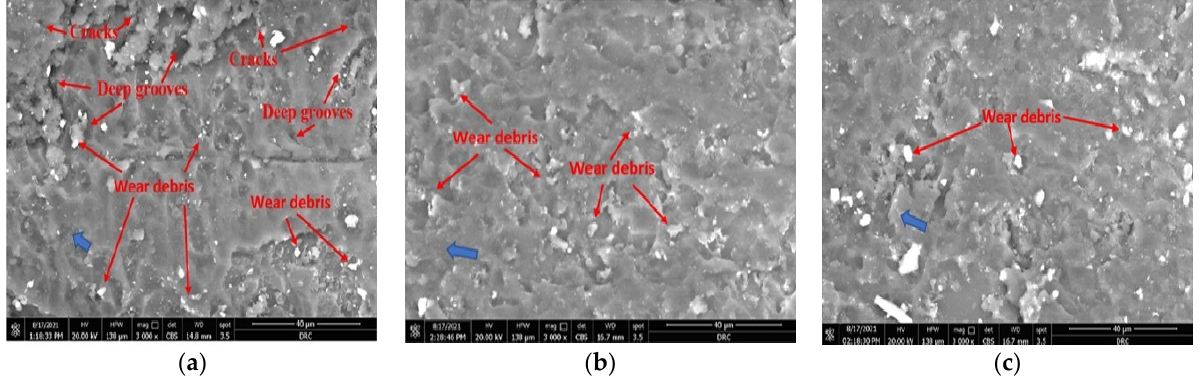
Figure 10. SEM photomicrograph of the worn surface after wear tests of: ( a ) epoxy/6 wt.% SiC, ( b ) epoxy/12 wt.%. SiC, ( c ) epoxy/18 wt.%. SiC. Note: Blue arrow refers to sliding